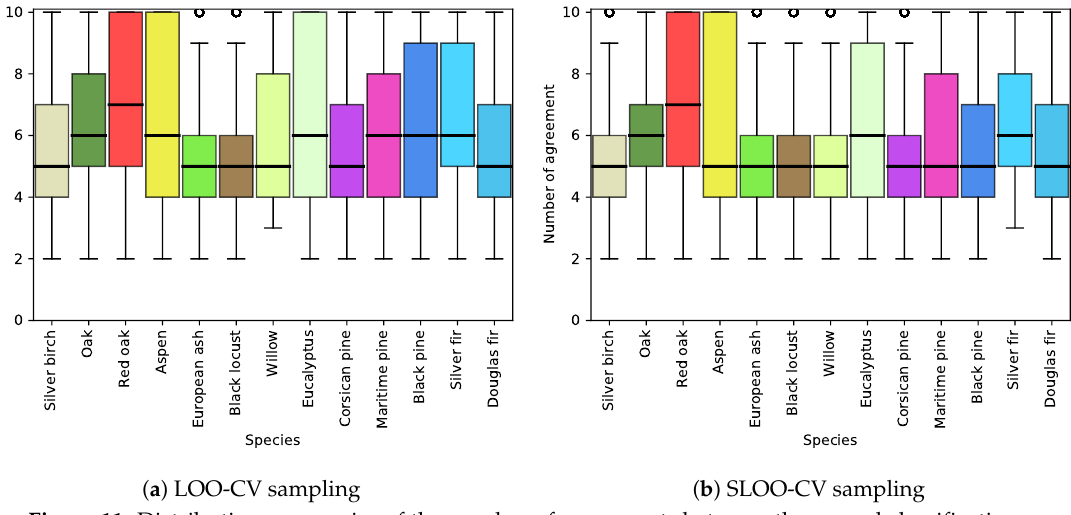
Figure 11. Distribution per species of the number of agreements between the annual classifications using all the predicted pixels for both the LOO-CV and SLOO-CV sampling